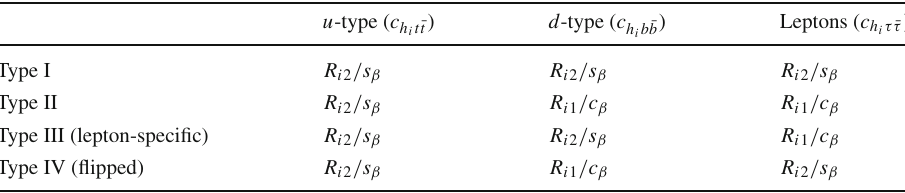
Table 3 Coupling factors of the Yukawa couplings of the N2HDM Higgs bosons h i w.r.t. their SM